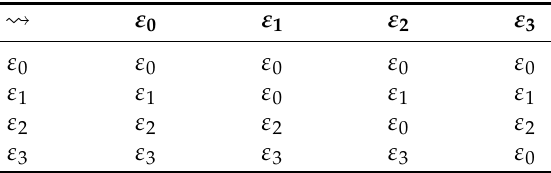
Table 3. Cayley table for the binary operation “ (cid:32)